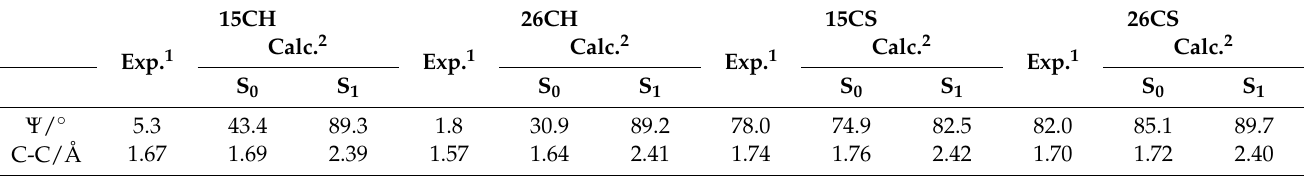
Table 1. Dihedral angles between the naphthalene plane and the bonding axis of the C-C bond in the o -carborane cage ( Ψ = C16–C15–C1(C2)–C2(C1) and bond lengths (C16–C15) of the C-C bond for 15CH , 26CH , 15CS , and 26CS